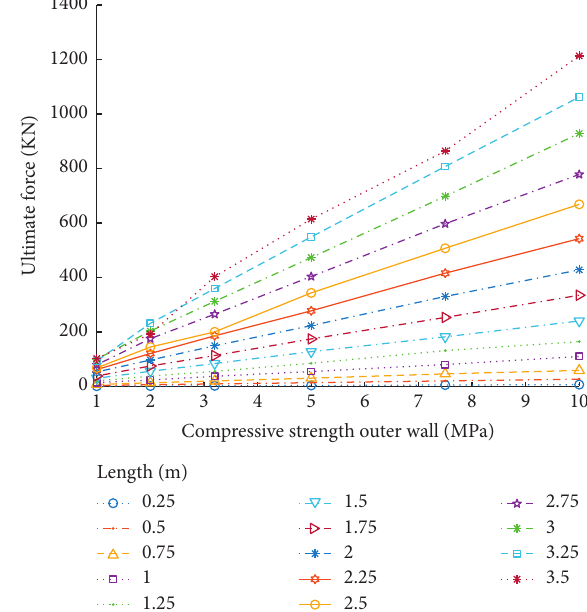
Figure 13: Yield displacement vs precompression ratio for dif- ferent heights.